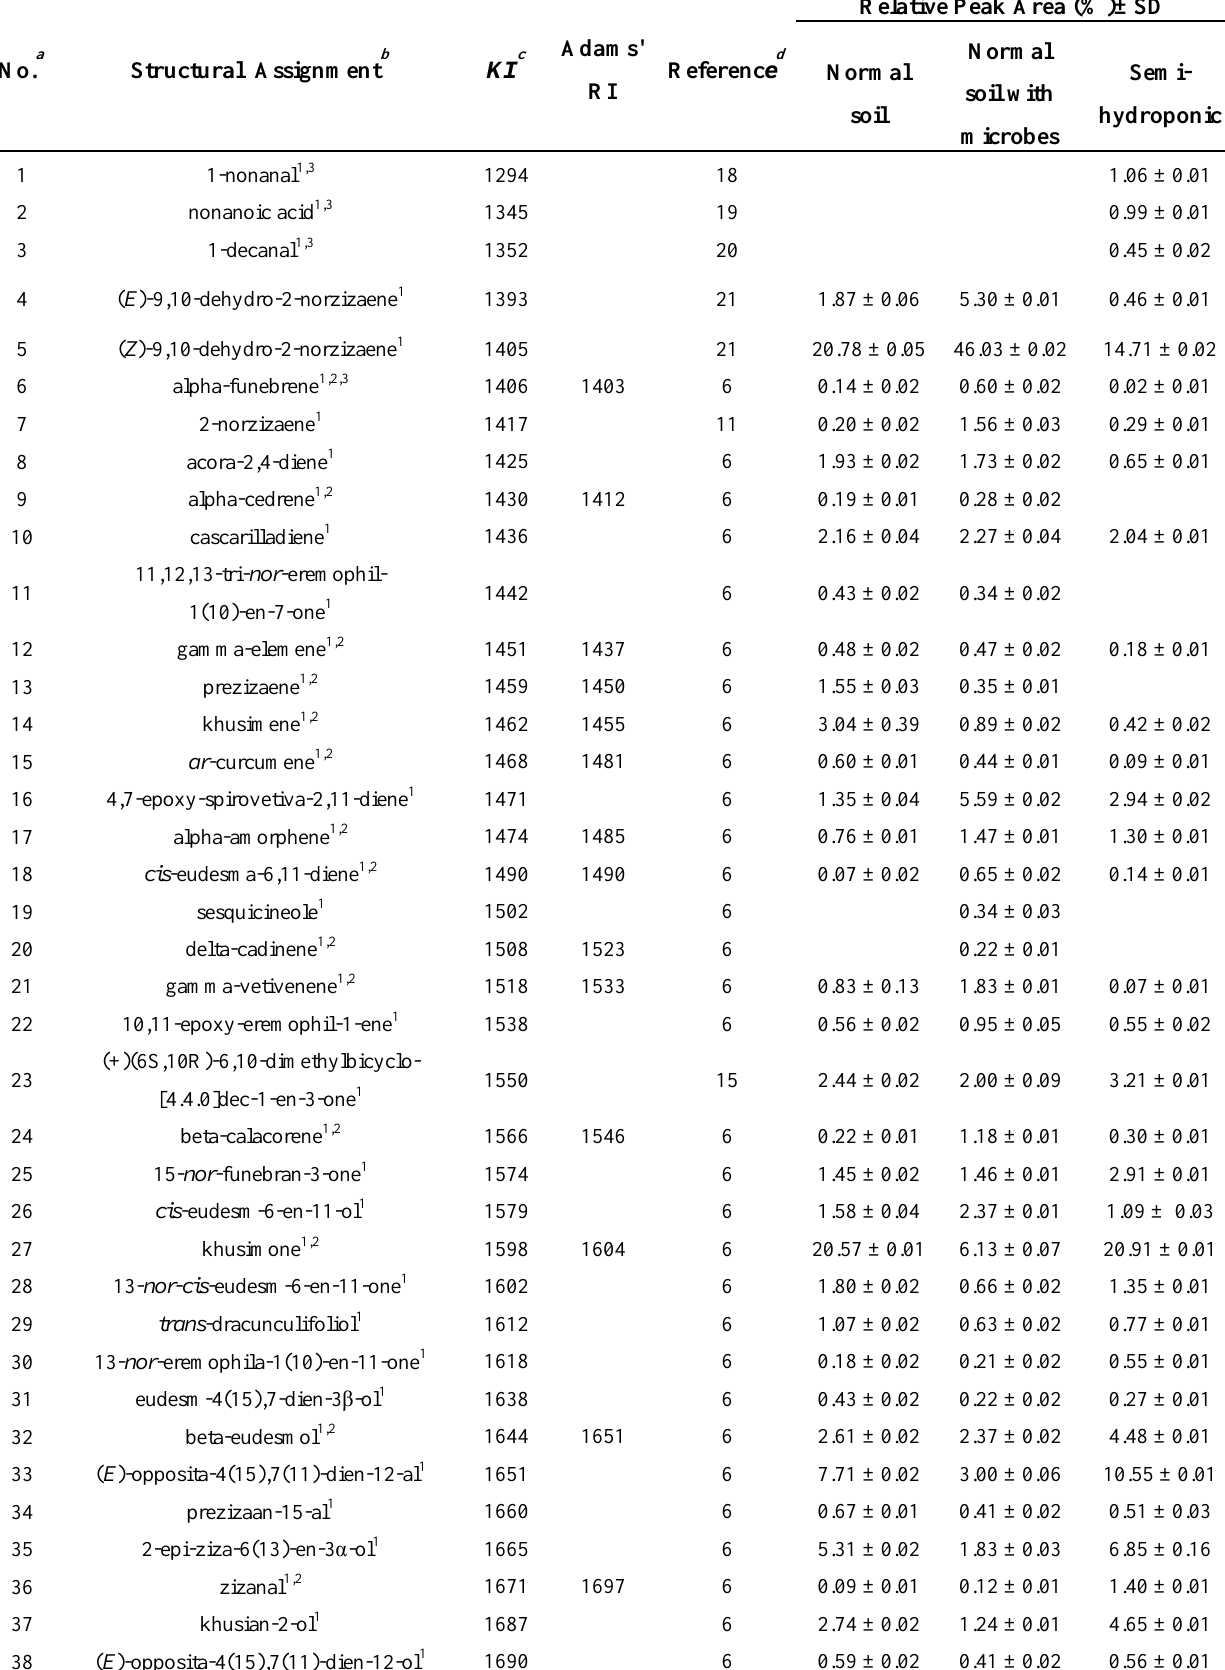
Table 1. Structural assignment and relative peak area percent of the volatile components in essential oils obtained from root of vertiver grass cultivated in three different